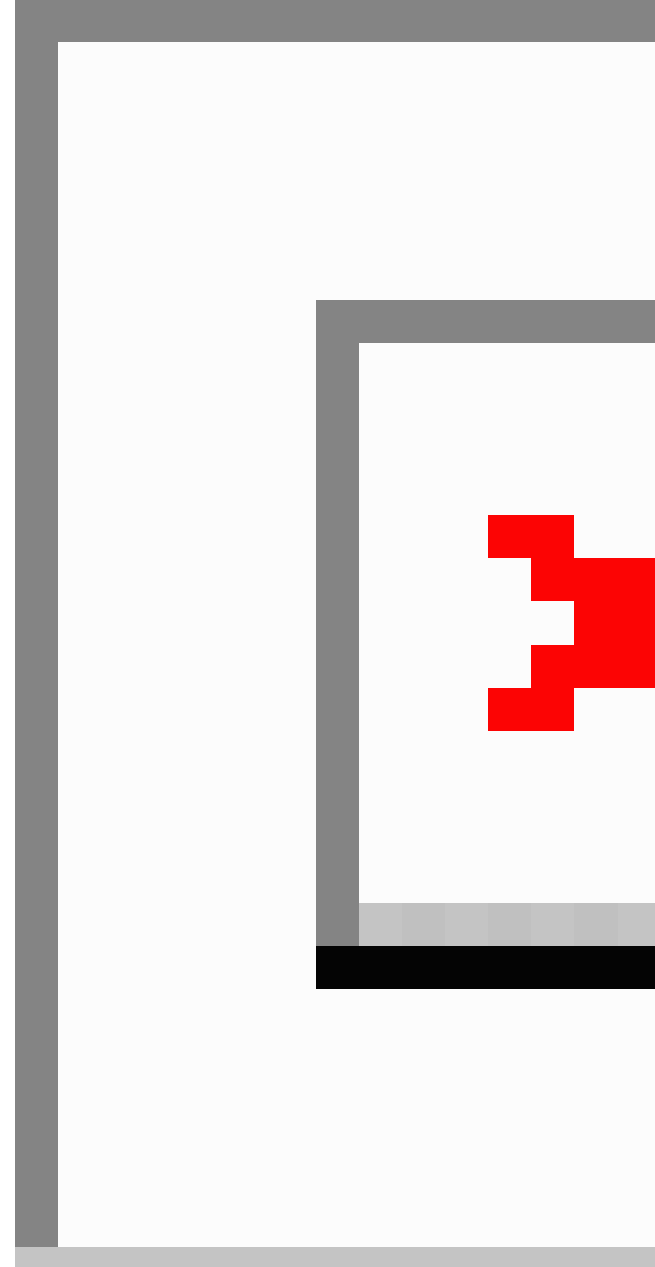
Figure 5. Processing time (seconds) of P2P Watch